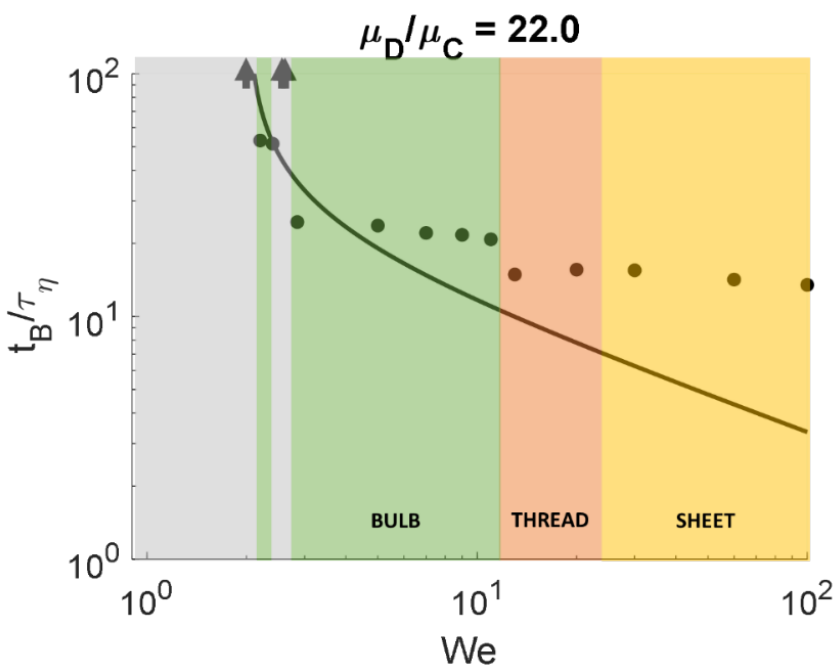
Figure 6. Time of initial breakup, t B , as a function of Weber number, We , for an intermediary viscosity drop ( μ D /μ C = 22). Solid line displays average breakup time as suggested by Rivière et al. [24]. Arrows indicate cases with t B > 90 τ η . Colored fields show breakup morphology; see Figure 2.